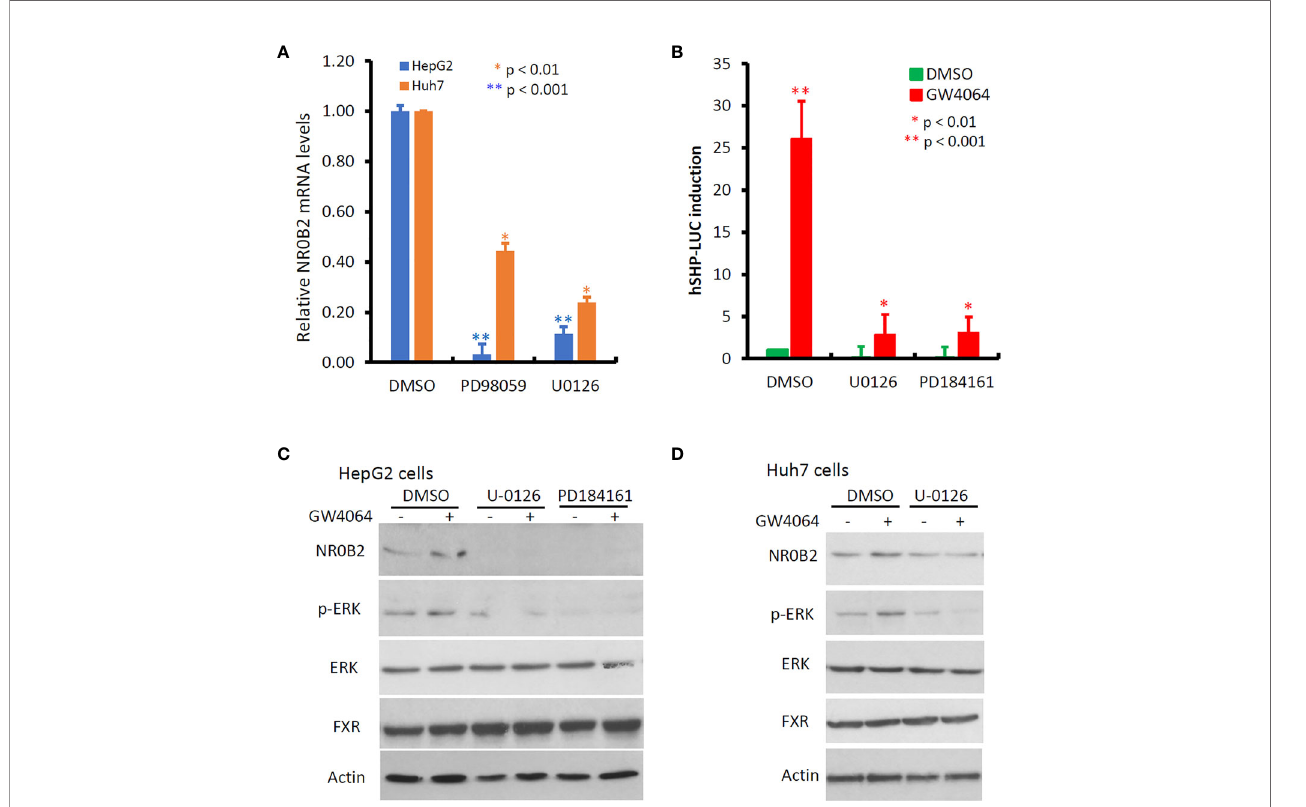
FIGURE 5 | MAPK activity is essential for NR0B2 gene expression in HCC cells. (A) HepG2 and Huh7 cells were treated with DMSO or MAPK inhibitors PD98059 (50 m M) and U0126 (10 m M) for 24 h. Total RNAs were extracted for qPCR assays. The relative expression levels of NR0B2 gene expression are calculated against the DMSO treatment (set as 1.0). Error bar indicates the SEM from three independent experiments. The asterisk indicates a signi fi cant difference compared to the DMSO control (Student t -test). (B) HepG2 cells were seeded in 6-well plates and then transfected with human NR0B2 promoter-driven luciferase reporter construct (hSHP-LUC, 0.5 m g DNA/well). Cells were pre-treated with MEK inhibitors U0126 (10 m M) and PD184161 (10 m M) for 30 min and then stimulated with GW4064 (5 m M) for 24 h. Luciferase assay was carried out as described in our publication (14, 15). The relative reporter activity was calculated against the DMSO control (set as 1). Error bar indicates the SEM from three independent experiments. The asterisk indicates a signi fi cant difference compared to the DMSO control (Student t -test). (C) HepG2 cells were pre-treated with U0126 (10 m M) and PD184161 (10 m M) for 30 min, followed by GW4064 (5 m M) stimulation for 24 h. Cells were harvested for western blot assays with the antibodies as indicated. Actin blot served as the protein loading control. (D) Huh7 cells were pre-treated with U0126 (10 m M) for 30 min, followed by GW4064 (5 m M) stimulation for 24 h. Cells were harvested for western blot assays with the antibodies as indicated. Actin blot served as the protein loading